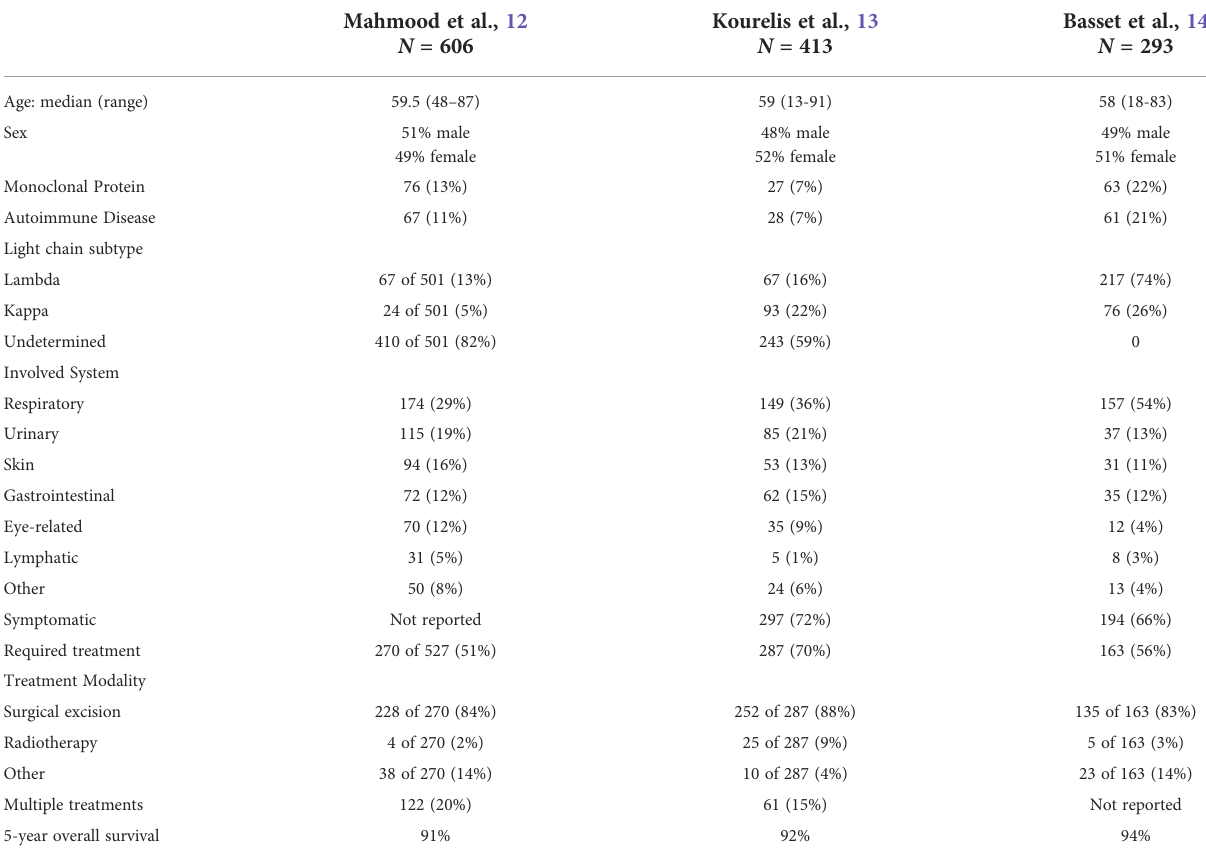
TABLE 1 Presentation and outcomes of patients with localized